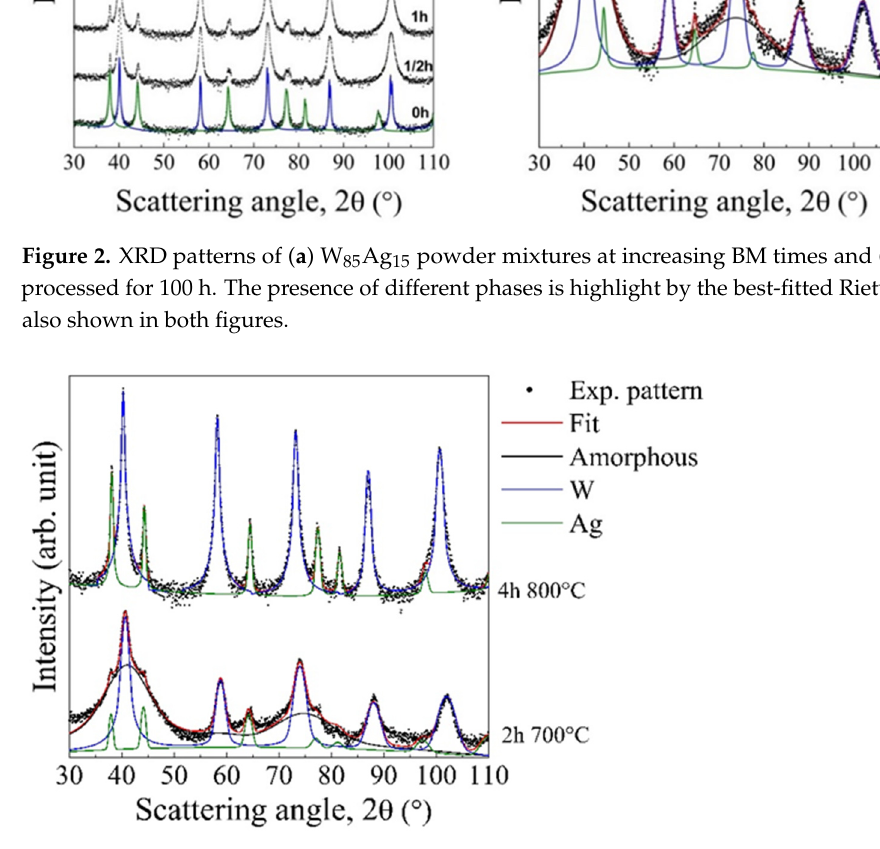
Figure 3. XRD characterization of ball milled (100 h) W 85 Ag 15 powders and subsequent thermal treatment at 700 °C and at 800 °C for 2 h and for 4 h, respectively.